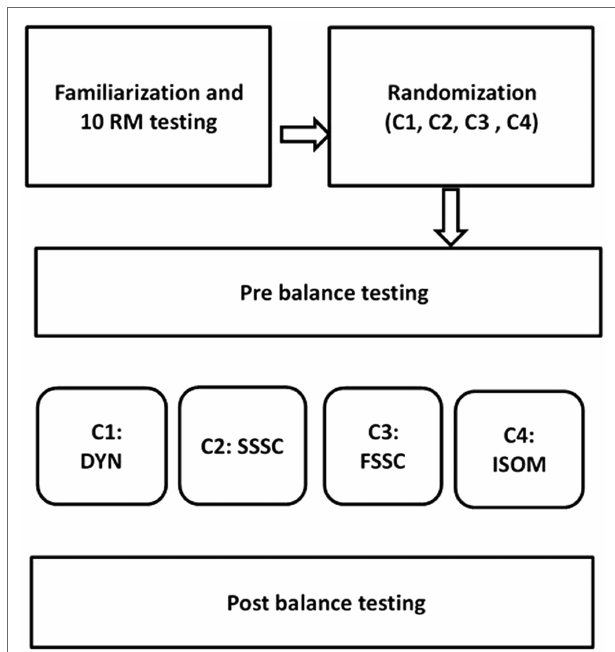
FIGURE 1 | Experimental design and study execution. DYN, dynamic strength exercise; ISOM, isometric strength exercise; SSSC, slow stretch- shortening cycle exercise; FSSC, fast stretch-shortening cycle exercise; 10 RM, 10 repetition